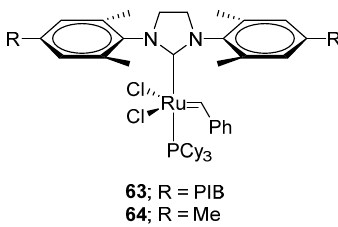
Figure 11. Polyisobutylene (PIB 1000 )-supported Grubbs second generation catalysts 63 and Grubbs catalyst 64 .